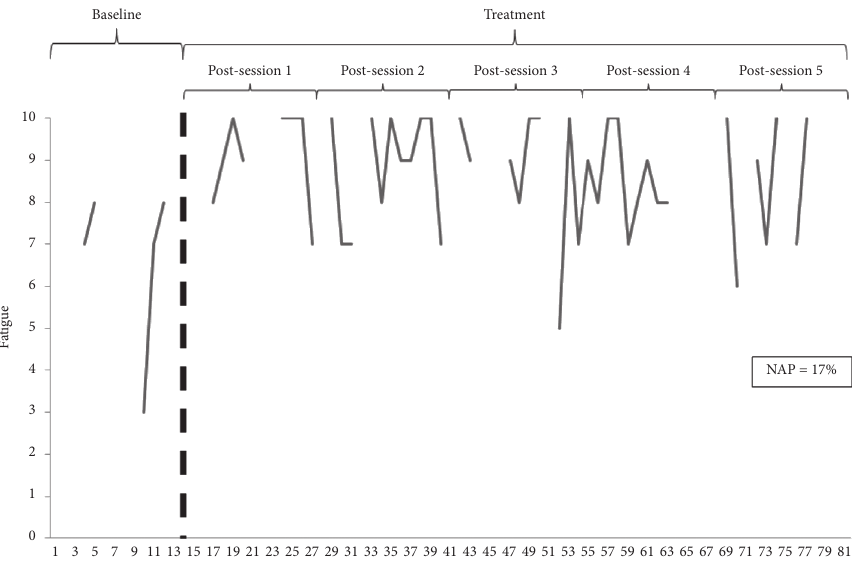
Figure 2: Patient 2 evolution in fatigue (no improvement). NAP: nonoverlap of all